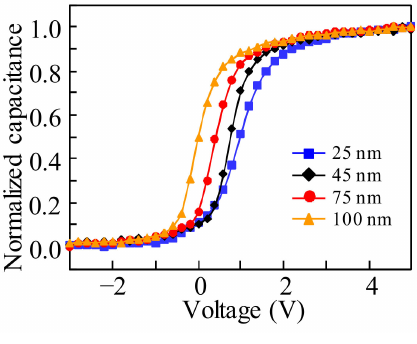
Figure 3. Capacitance–voltage ( C – V ) characteristics of the indium tin oxide (ITO)/IGZO/SiO 2 /Cr stack structure with various T IGZO .